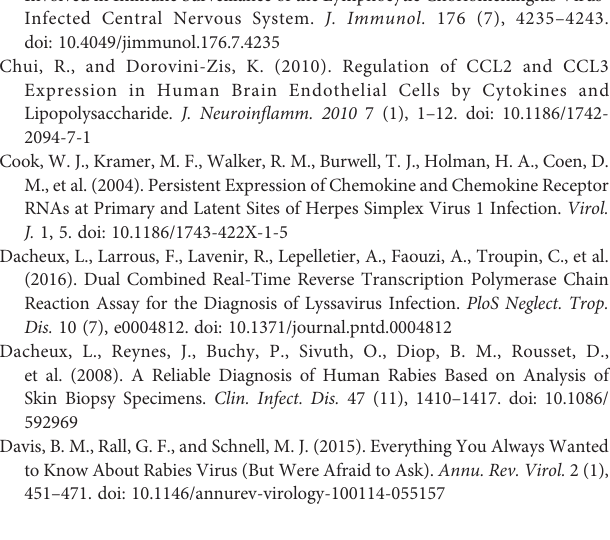
Supplementary Figure 6 | Quanti fi cation of RABV N-protein, M-protein, and P- protein gene expression in the human BSC by qPCR. In detail, expression of viral genesinnon-infectedhumancontrols(n=4;IPC38,IPC39,IPC40,IPC41)andrabid patients (n=4; IPC02, IPC08, IPC12, IPC15) were quanti fi ed in the human BSC by